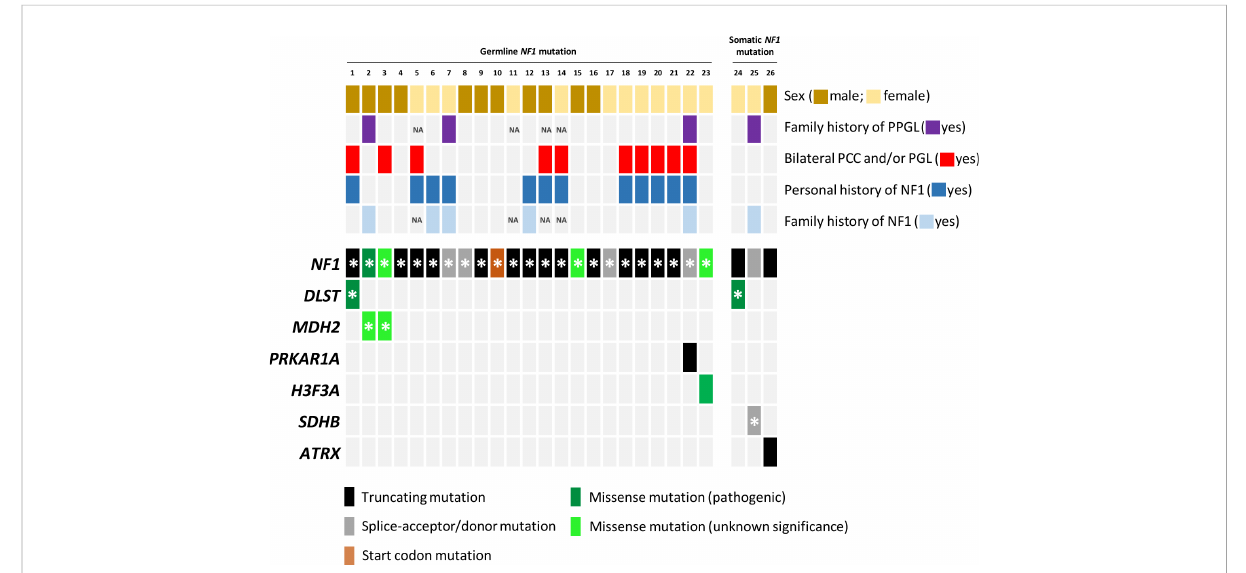
FIGURE 1 Mutational pro fi le of the twenty-six samples included in the study. Each column represents a tumour, with coloured rectangles representing mutations that are germline (denoted with an asterisk) or somatic in each row. Missense variants that ClinVar does not classify as pathogenic mutations and/or that are absent in NF1 patients were categorized as variants of unknown signi fi cance. NA, not